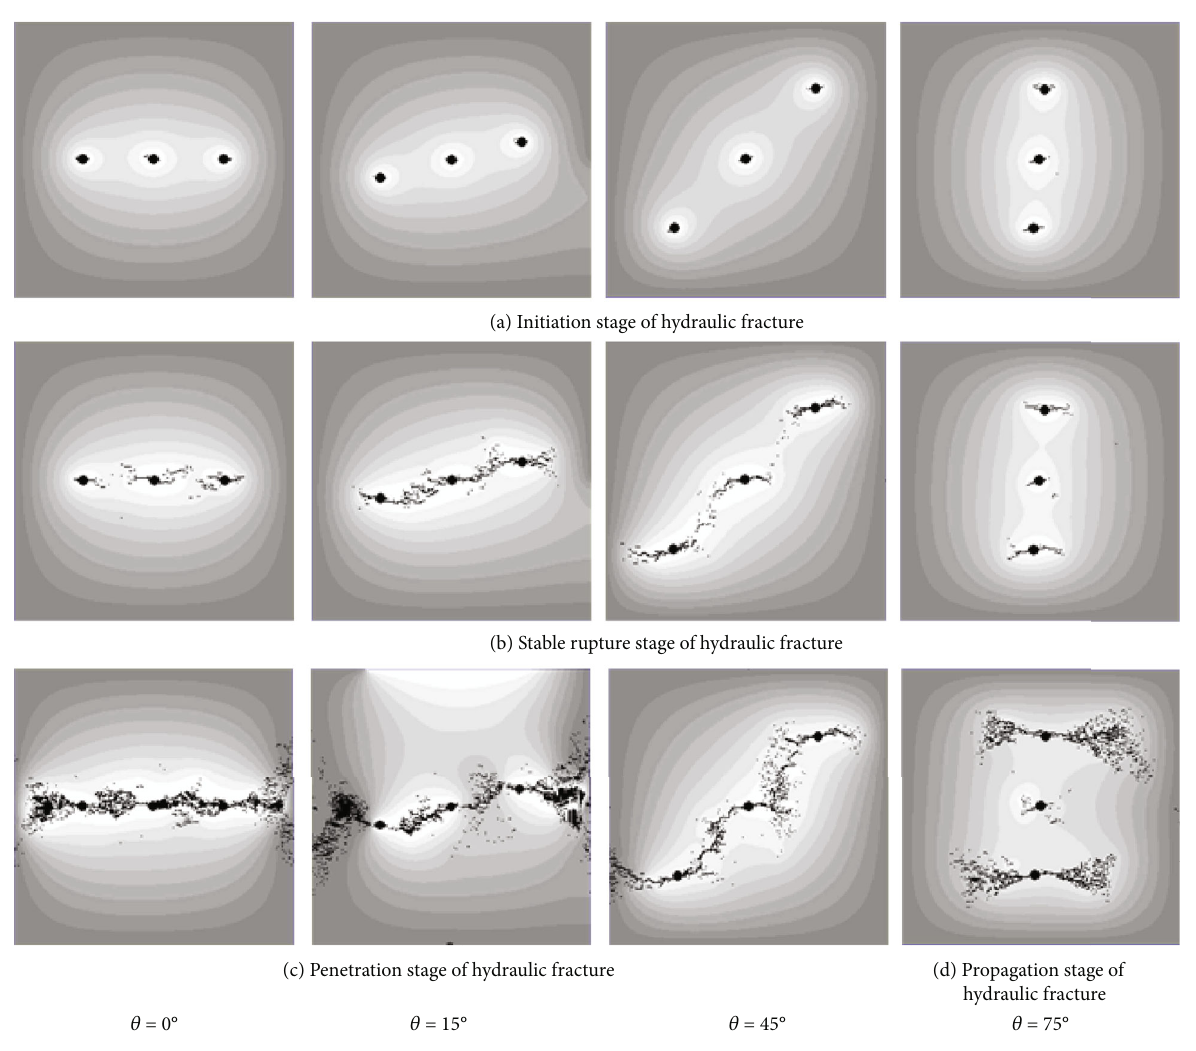
Figure 4: Initiation, propagation, and penetration process of multihole linear codirectional fractures at di ff erent angles between the direction of hole distribution and maximum principle stress σ 1